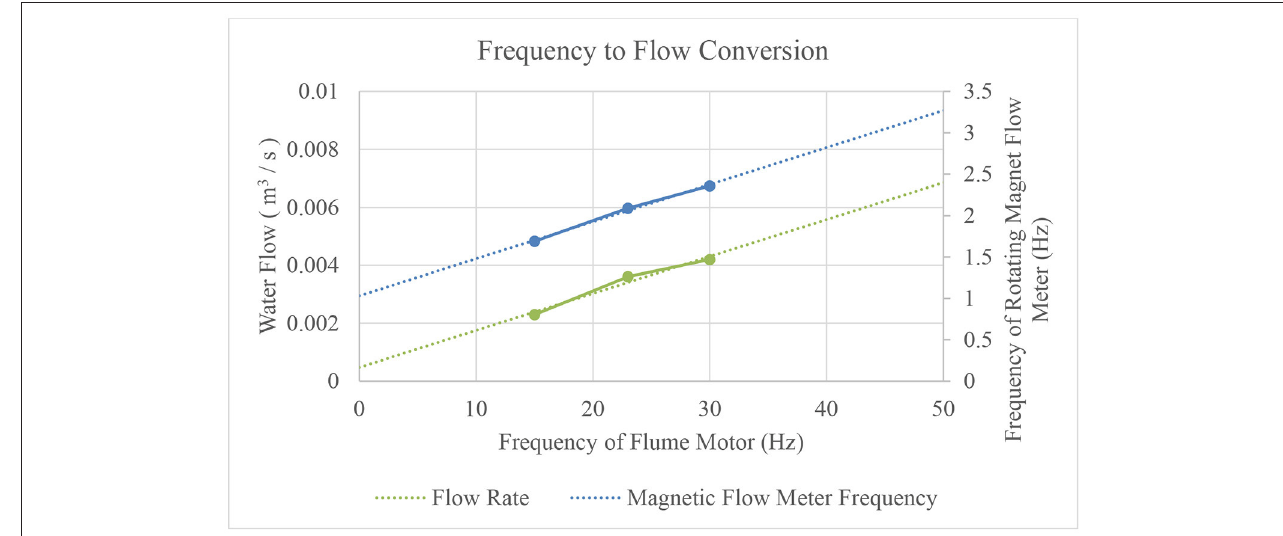
FIGURE 17 | Frequency to flow conversion for rotating magnet flow